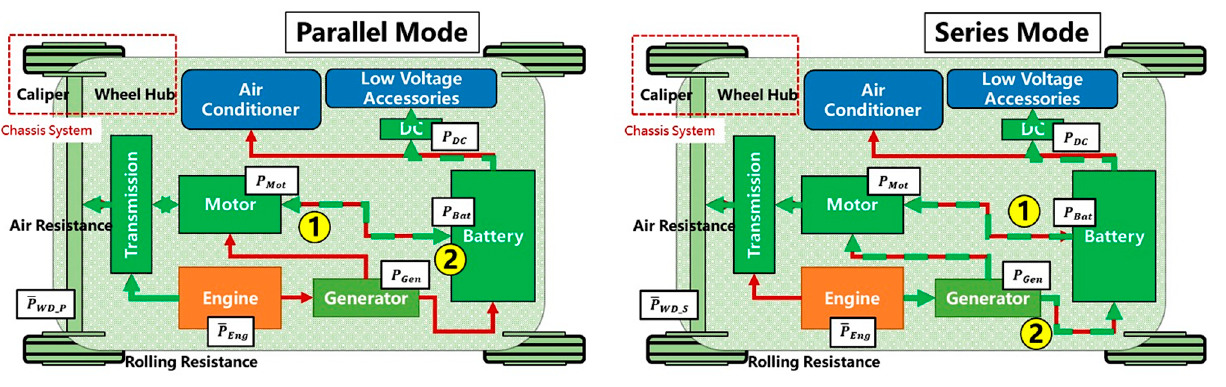
( b ) Series mode energy flow.